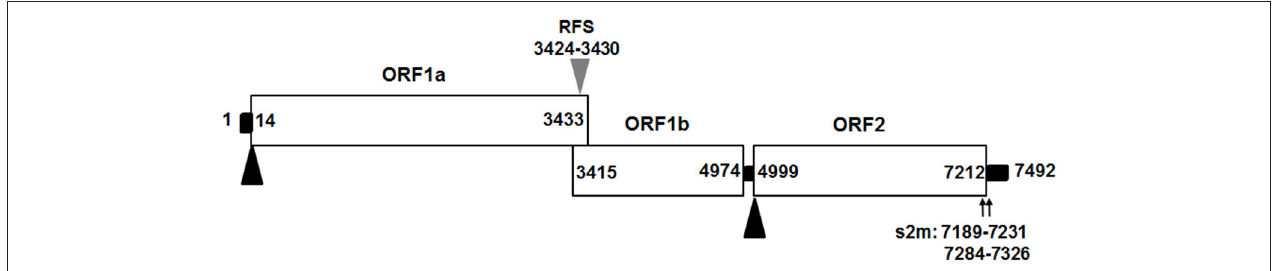
FIGURE 2 | Predicted genome organization of CAstV NJ1701. Three predicated ORFs with their locations for CAstV NJ1701 are shown. The translation start sites of ORF1a and ORF2 are indicated by black triangles. The nucleotide position of the start site of the heptameric AAAAAAC (RFS) sequence are shown by gray triangles. Black bars are the untranslated regions and the 24-nt spacer between the stop and start codons of ORF1b and ORF2, respectively. ORF, open reading frame; RdRp, RNA-dependent RNA polymerase; RFS, ribosomal frameshift signal; s2m, stem-loop-II-motif.